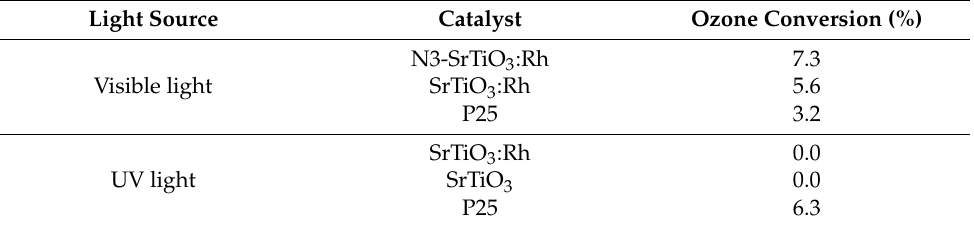
Table 2. Ozone removal rate in a flow system under two different light sources (SV = 7250 L